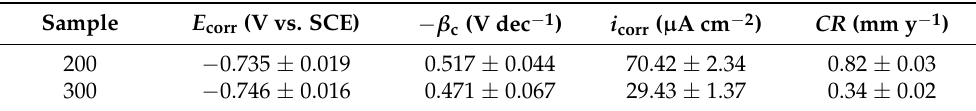
Table 7. Potentiodynamic polarization parameters obtained after 24 h of immersion in a 3.5 wt.% NaCl aqueous solution saturated with CO 2 .